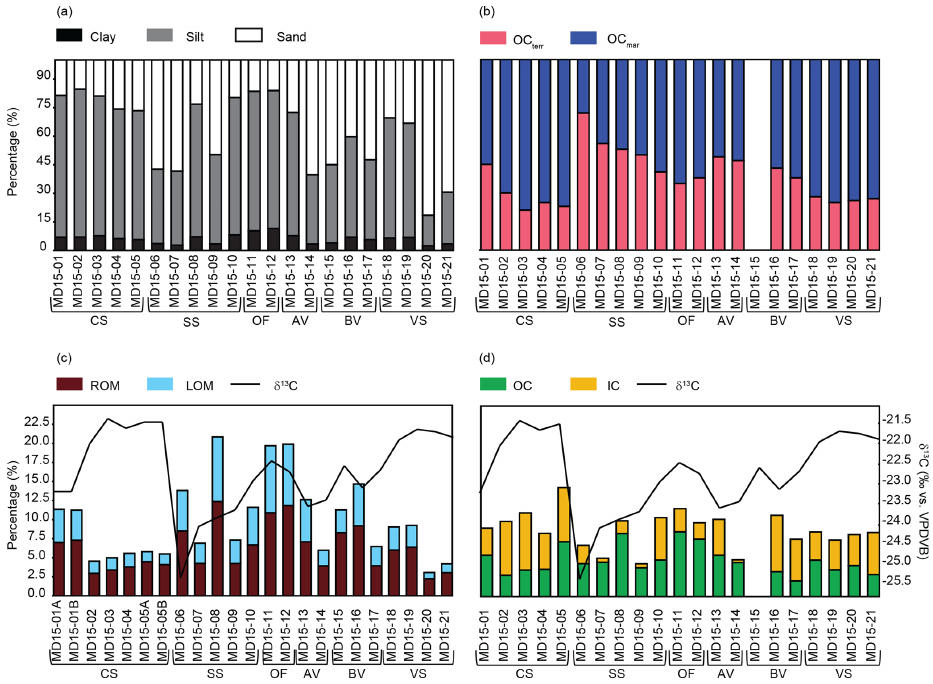
Figure 3. Sediment physical properties. (a) Particle size analysis. (b) Fraction of terrestrially sourced OC (OC terr ) and marine-sourced OC (OC mar ) at each site. (c) Refractory and labile organic matter content at each site and carbon stable isotope. (d) Inorganic and organic carbon percentage at each site and carbon stable